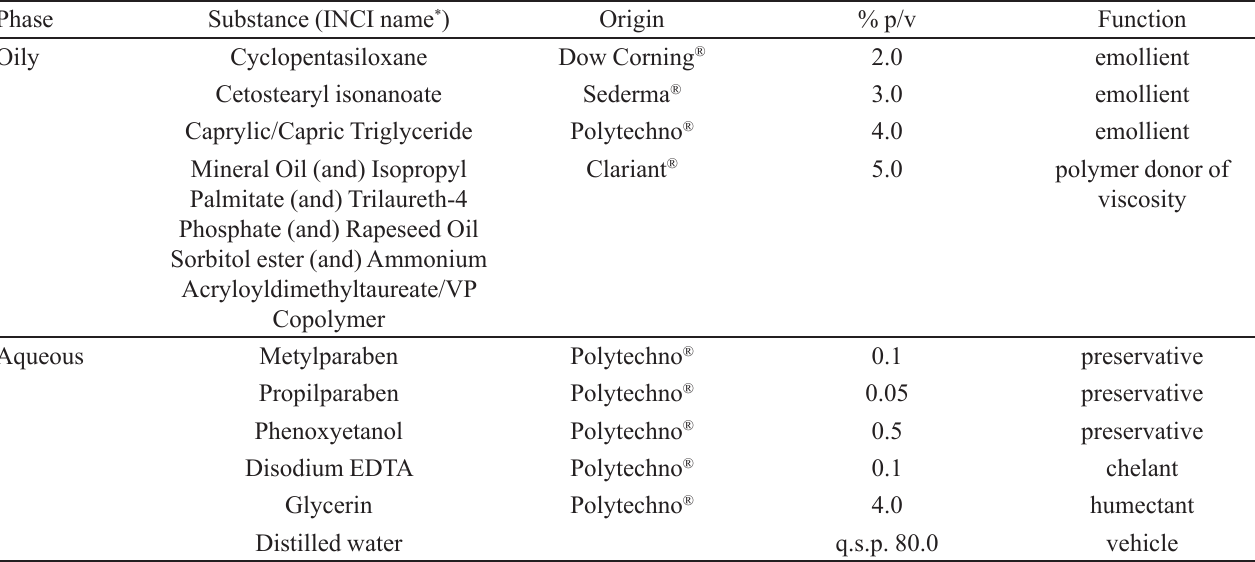
TABLE I – Base formulation (emulsion) composition